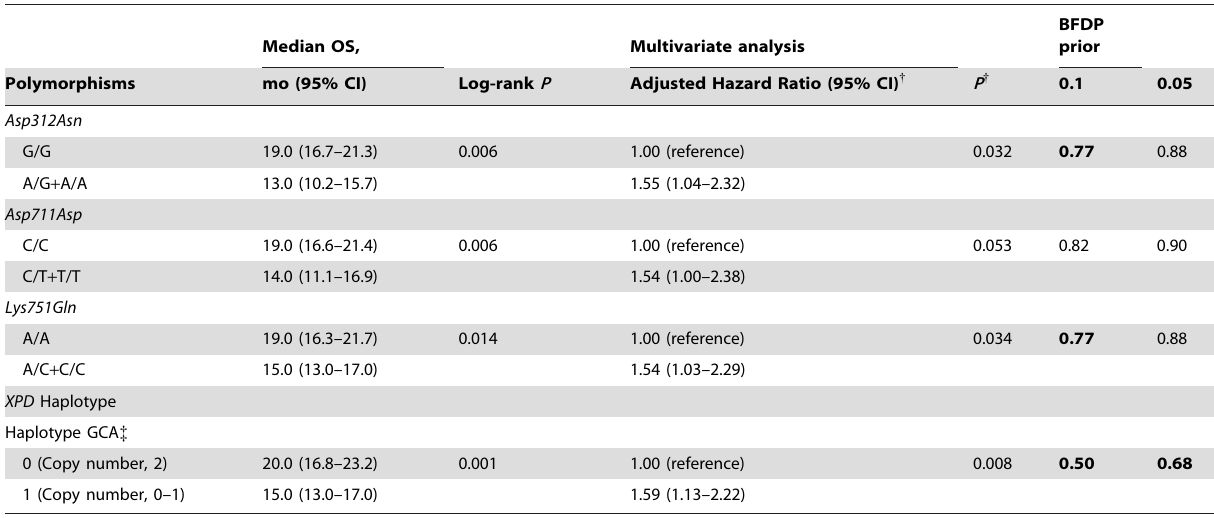
Table 4. Polymorphisms associated with OS.